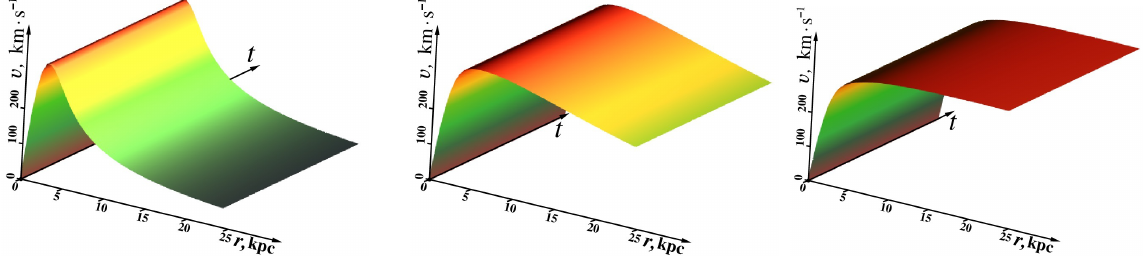
Figure 3. Orbital velocity (68) and (69) for N = 1, N = 10, N = 100 from the left to right,